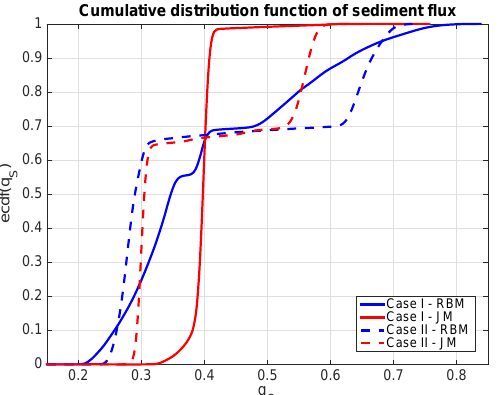
Figure 11. Unsteady simulations with four consecutive floods. Em- pirical cumulative distribution functions of specific sediment flux. Blue lines identify the rough-bed model and red the jamming model. Solid lines identify the constant input case (Case I) and dashed lines the variable input case (Case II).